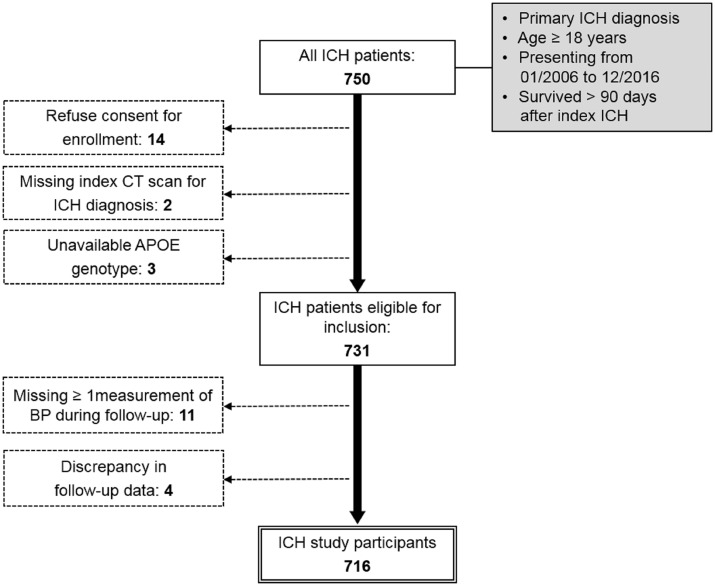

Study inclusion/exclusion criteria and enrolment flow diagram. Figure presents study design, inclusion/exclusion criteria and composition of patient group retained for analysis. Solid single-line boxes represent subjects meeting criteria for inclusion in the present study at each step. Eligibility criteria for inclusion in the study are listed in grey-background boxes. Dashed lines connect to dashed-bordered boxes listing criteria for exclusion and the number of subjects excluded. The double-line bordered box indicates the final study group selected for analyses mentioned in the Results section. ICH = intracerebral haemorrhage.